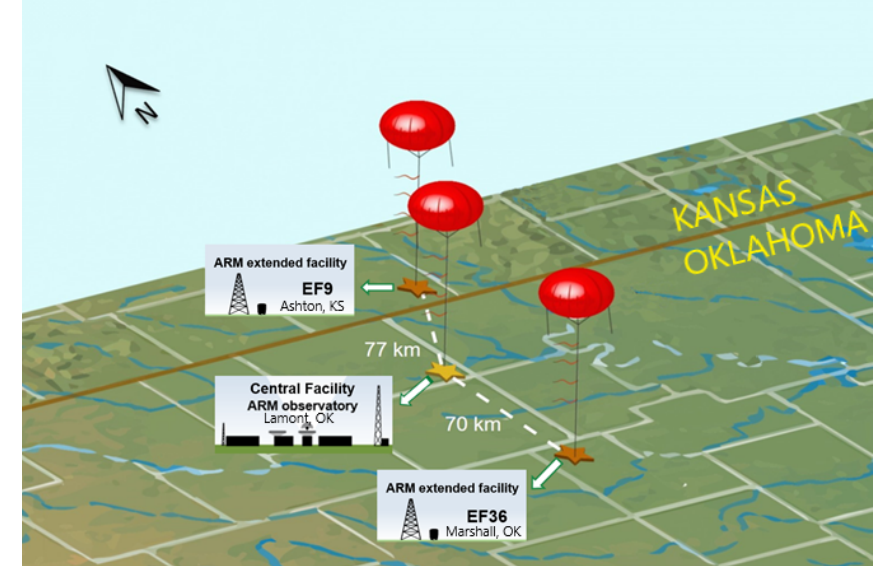
Figure 1. Map of the TBS deployment locations for flights conducted in